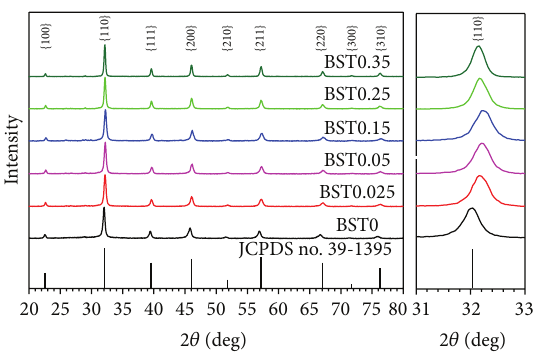
Figure 2: The XRD patterns of BST powders with various